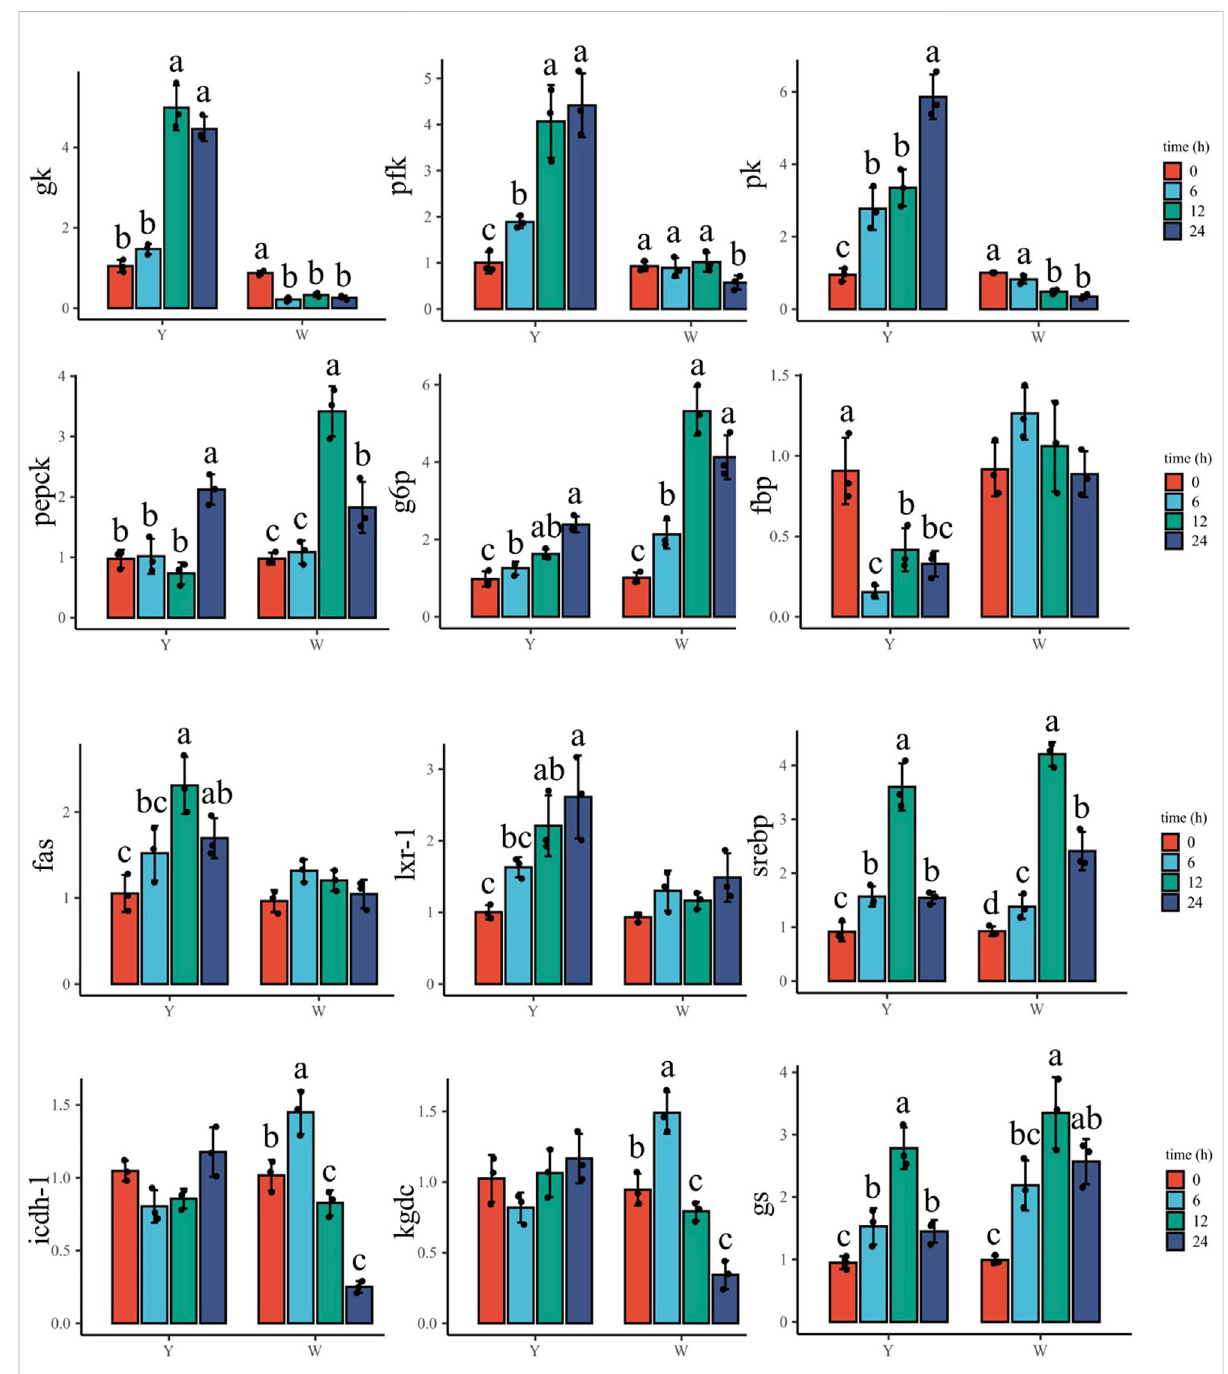
FIGURE 4 Expression of muscular genes involved in glucose overload response. Data are expressed as mean + SD ( n = 12). Different letters indicate signi fi cant differences ( p < 0.05). gk , glucokinase; pfk , phosphofructokinase; pk , pyruvate kinase; pepck , phosphoenolpyruvate carboxykinase; g6p , glucose-6-phosphatase; fbp , fructose bisphosphatase; fas , fatty acid synthetase; lxr-1 , liver X receptor-1; srebp , sterol regulatory element-binding protein; icdh-1 , isocitrate dehydrogenase-1; kgdc , alpha-ketoglutarate dehydrogenase complex; gs , glycogen